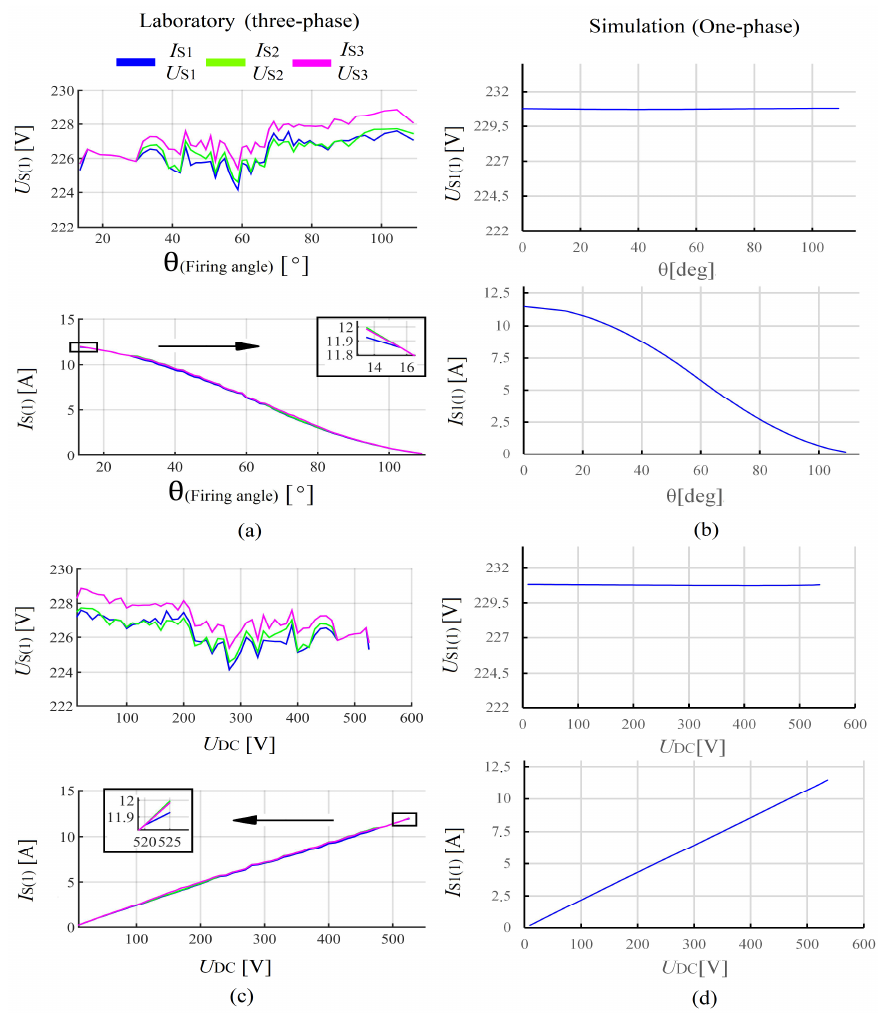
Figure 8. Comparison between laboratory and simulated characteristics: ( a , b ) PCC voltage and current fundamental harmonic vs. rectifier firing angle; ( c , d ) PCC voltage and current fundamental harmonic vs. rectifier DC voltage.